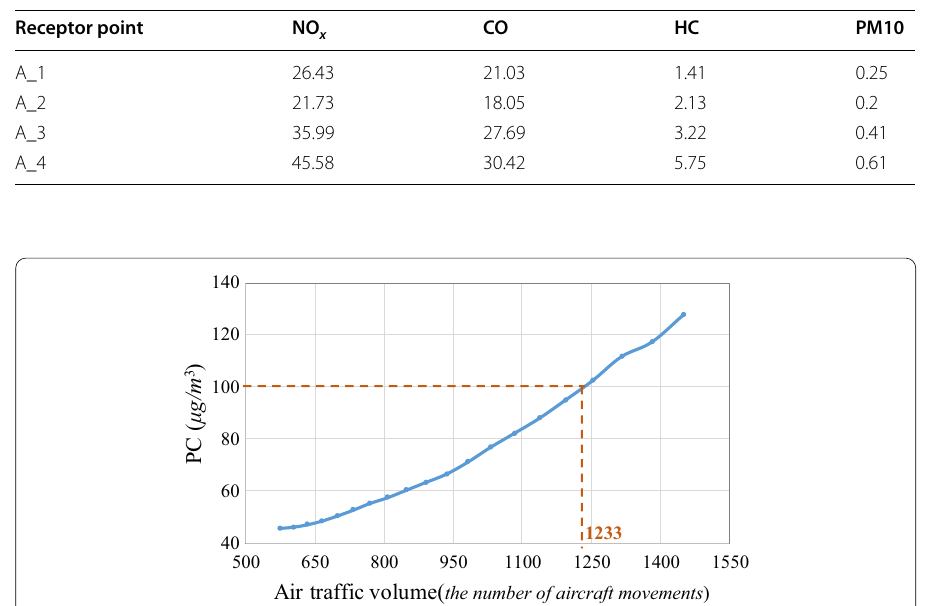
Table 5 Daily pollutant concentration of each receptor point (μg/m 3 )